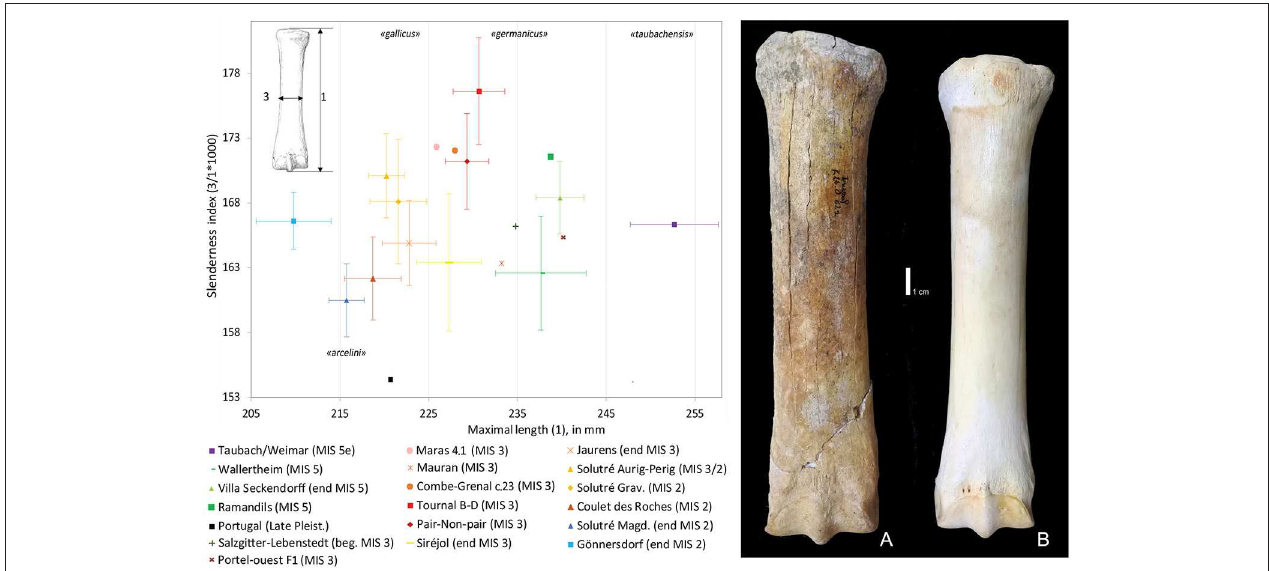
FIGURE 8 | Bivariate diagram of slenderness index (SI 1) in relation to the maximal length of the metacarpal. Slenderness index (SI 1): breadth at the middle of the diaphysis (3)/maximal length (1)*1,000. Confidence interval scale bars (95%) for series with more than 5 specimens. Data: Taubach/Weimar (Eisenmann, pers. comm.); Wallertheim (Nobis, 1971); Villa Seckendorff, Salzgitter-Lebenstedt, Solutré Gravettian, Gönnersdorf (Cramer, 2002); Combe-Grenal, Solutré Aurignacian-Perigordian ( Guadelli, 1991); Mauran (Eisenmann and David, 1994); Pair-non-Pair (Prat, 1968); Siréjol, Jaurens (Eisenmann, 2019);